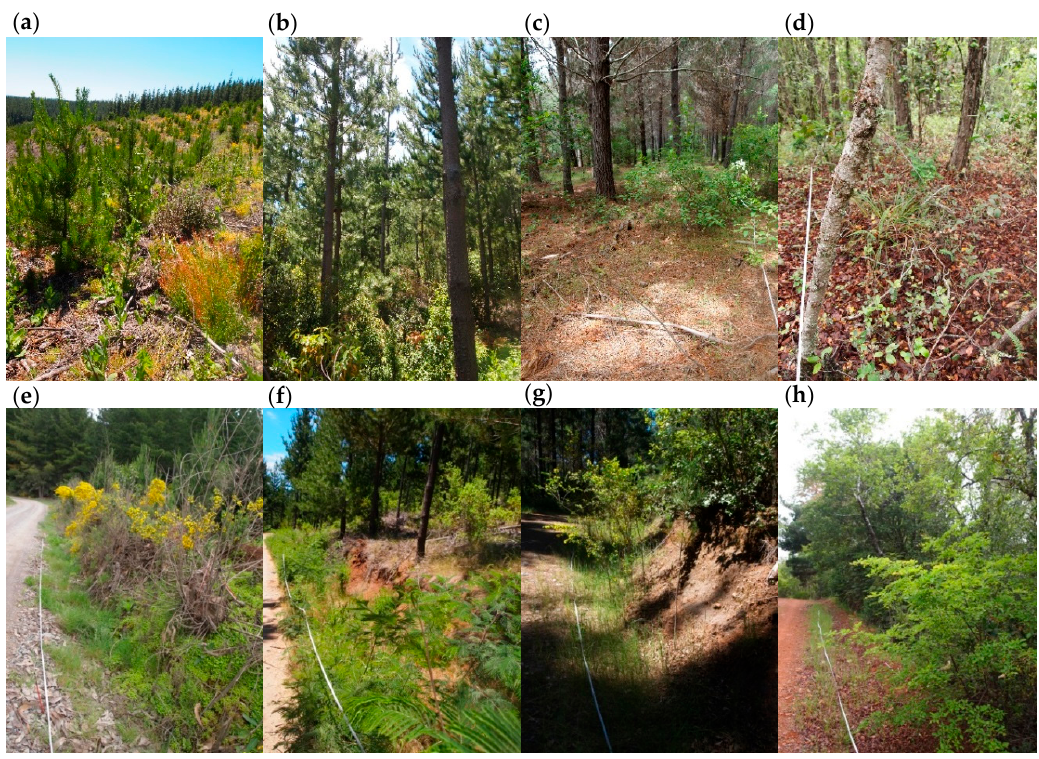
Figure 2. Example transects in forest interiors ( a – d ) and along roadsides ( e – h ). Transects were established in and adjacent to young plantations ( a , e ), in and adjacent to medium-aged plantations ( b , f ), in and adjacent to old to mature plantations ( c , g ) and in and adjacent to natural forests ( d , h ).